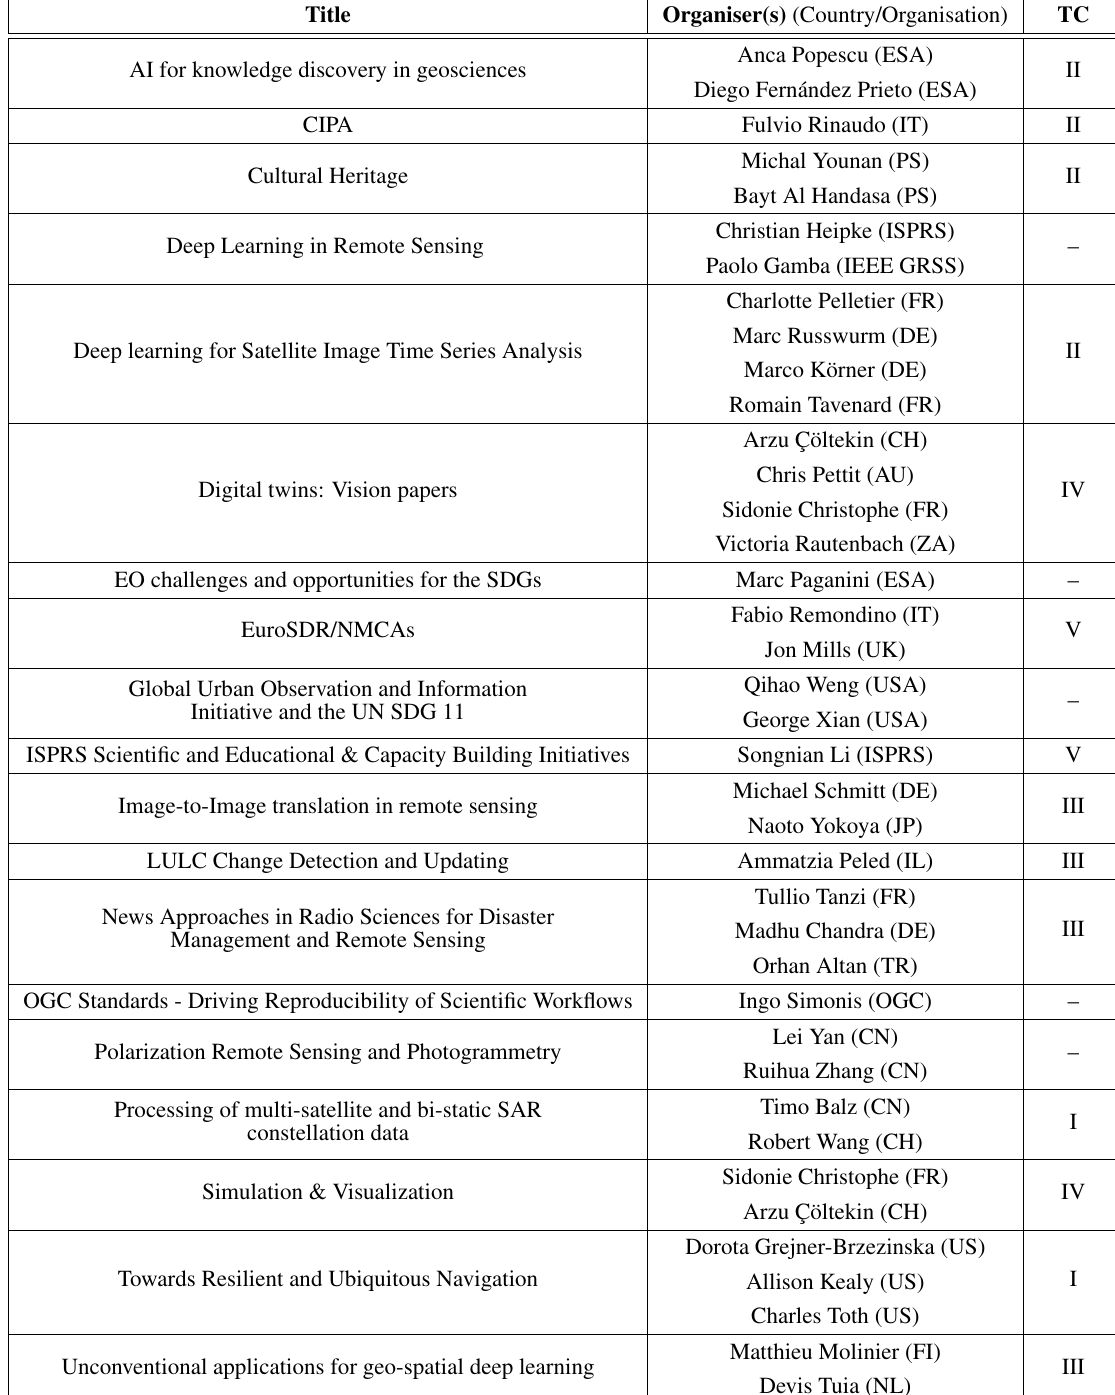
Table 1. Thematic Sessions of the 2021 edition of the ISPRS Congress. ”–” means no papers were published in the